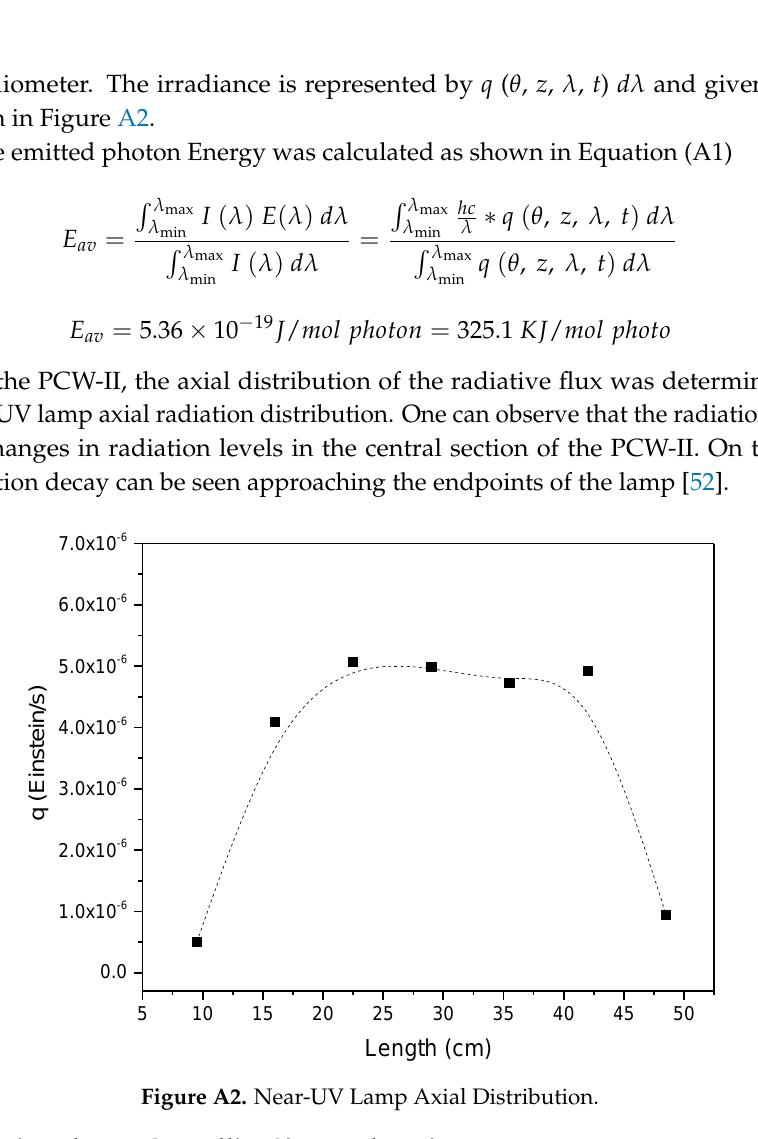
Table A1. Photocatalyst Crystallite Sizes.